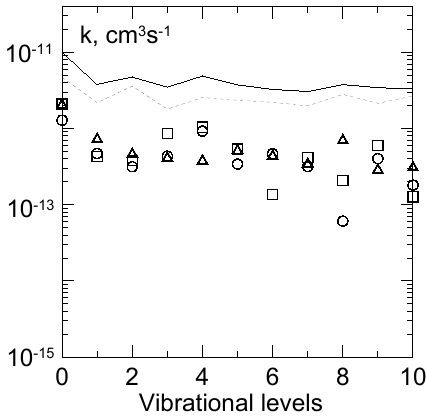
Fig. 9. The same as in Fig. 7, but for the vibrational level v =2 of O 2 (X 3 6 − g ) Figure 9. The same as in Fig.7, but for the vibrational level v=2 of O 2 (X 3 Σ g– ).